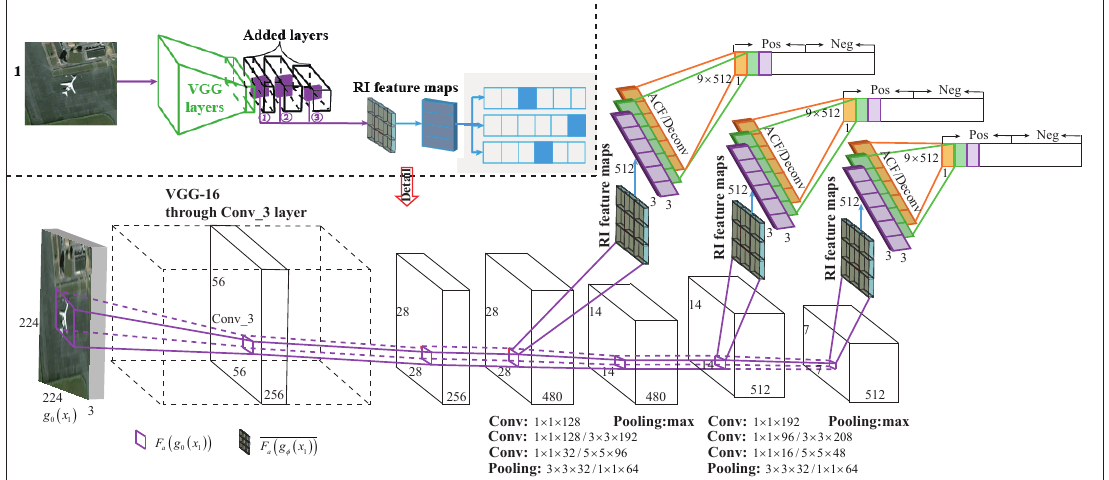
Figure 2. The detailed architecture of the rotation-insensitive convolutional channel features.